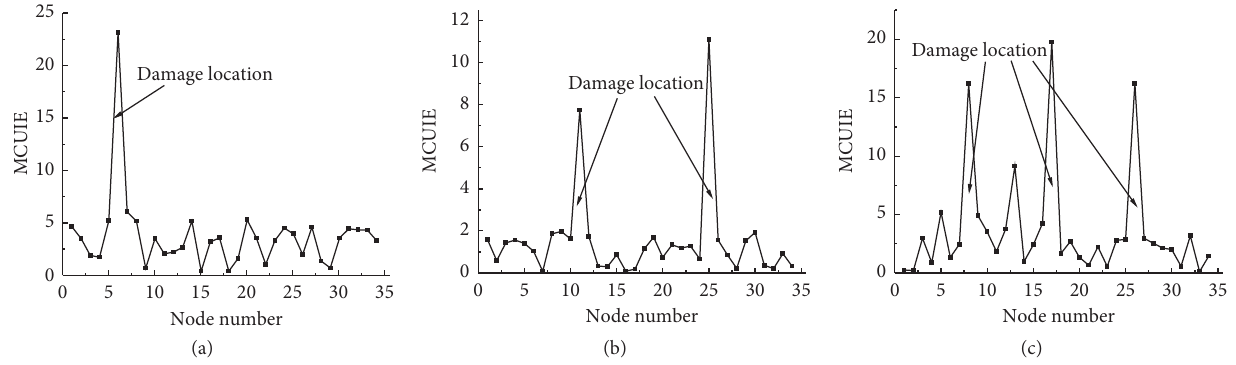
Figure 25: Damage identification result of MCUIE. (a) Case 6. (b). Case 7. (c) Case 8.